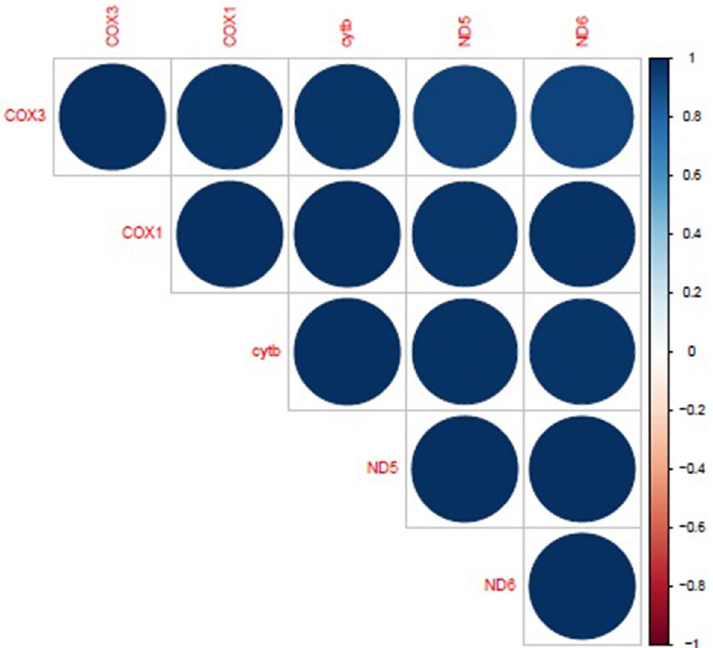
Figure 1. Correlogram highlighting the correlation between DEGs in skeletal muscle tissue from high and low RFI heifers. Visual representation of the correlation matrix highlighting the most correlated DEGs in skeletal muscle tissue from high and low RFI heifers. Blue circles (correlation value 1) indicate a high correlation between DEGs. Non-significant correlations are denoted as X. This image was generated through the use of the R (v3.4) Corrplot package 65